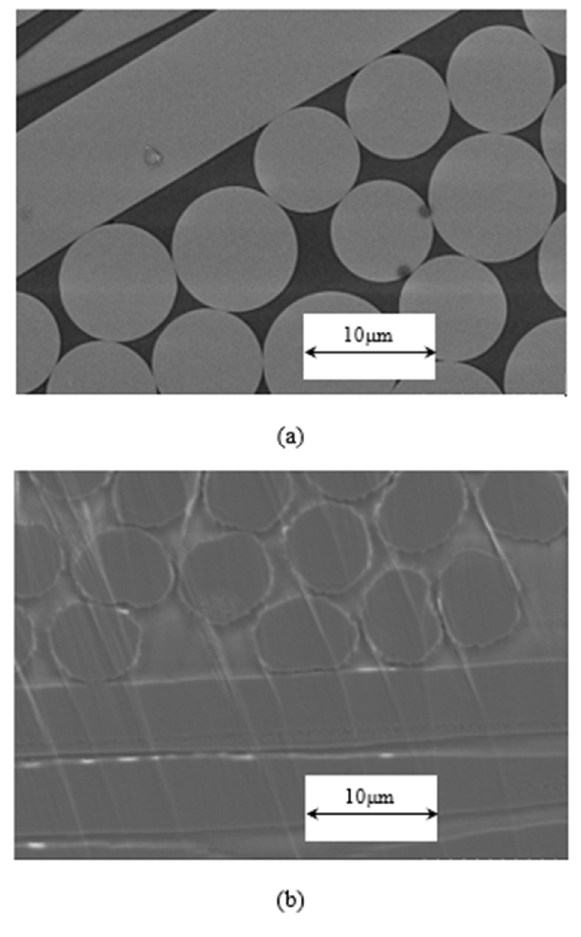
Figure 7. SEM images of cross section of ( a ) C-GFRTP and ( b )